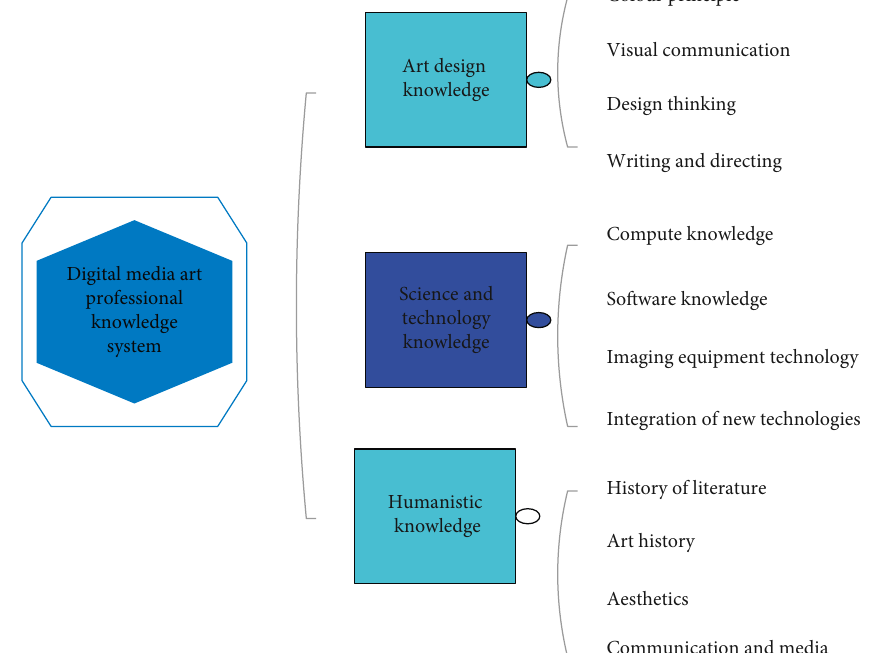
Figure 4: Diagram of the professional knowledge system of digital media art.